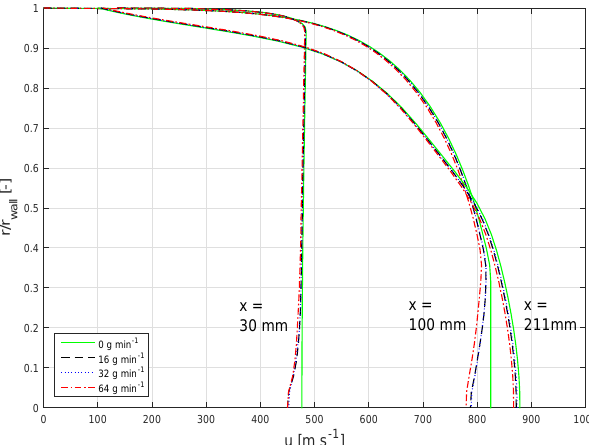
Figure 10. Comparison of titanium particle velocity profiles along axial position (coupled) Figure 11. Comparison of gas velocity profiles along radial posi- tion